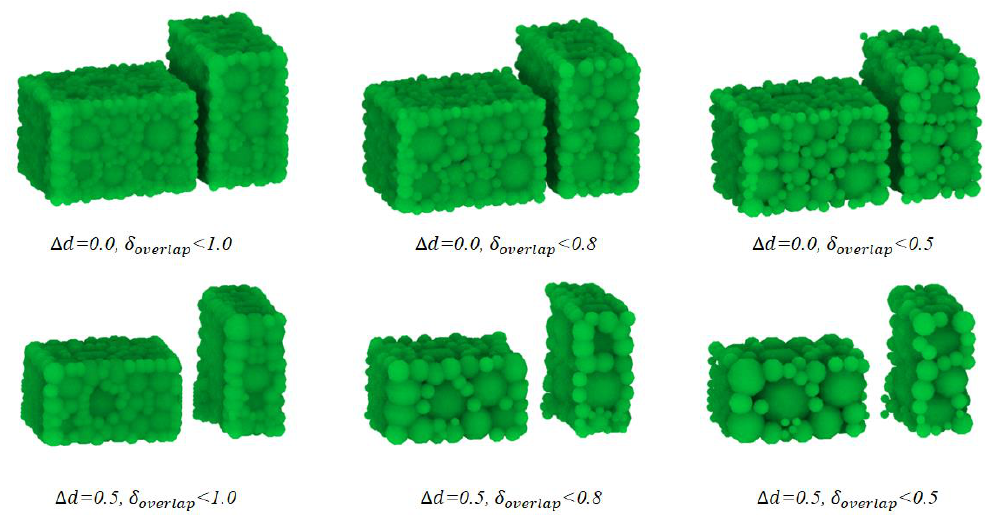
Figure 7. Sphere packing results obtained with different thresholds and overlap ratios for DT map segmentation.